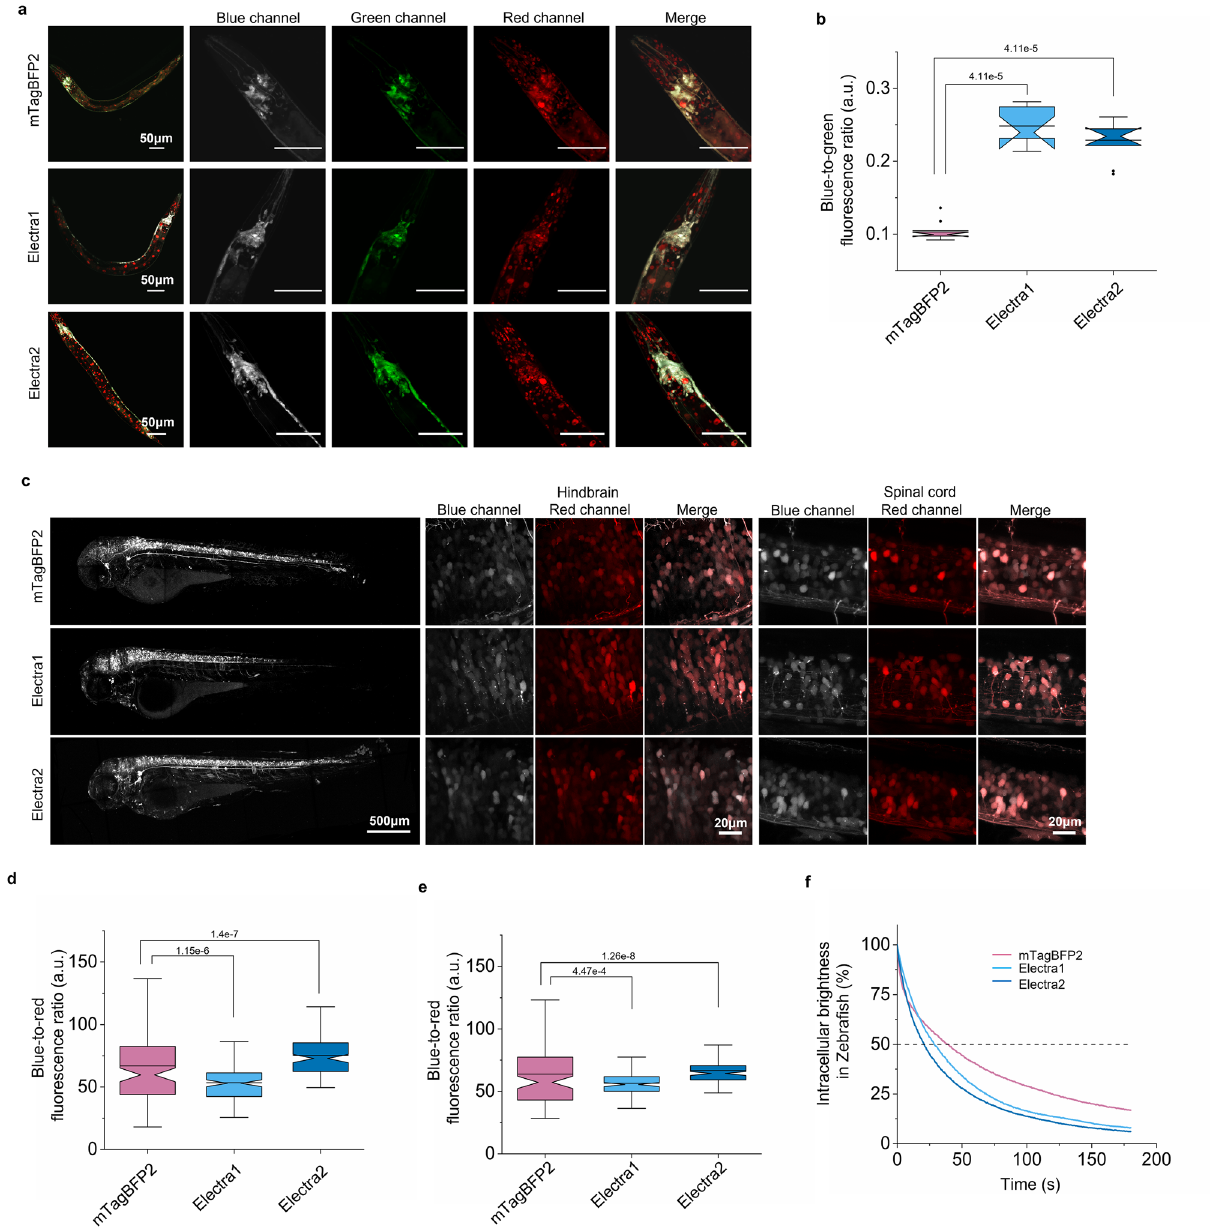
Figure 6. Fluorescence comparison of mTagBFP2, Electra1 and Electra2 in small model organisms. ( a ) Whole body images of representative C. elegans worms co-expressing mTagBFP2, Electra1 and Electra2 with mNeonGreen under pan-neuronal promoter tag168 and mScarlet in most somatic cells. Higher magnification images of neuronal ring under blue (shown in grey), green (mNeonGreen), red channel (mScarlet) and merged. Imaging conditions: 405 nm excitation for BFPs, 430–470 nm emission; 488 nm excitation for mNeonGreen, 500–540 nm emission; 561 nm excitation for mScarlet, 570–620 nm emission. The dynamic range of all images was adjusted independently to facilitate visualization. ( b ) Blue-to-green fluorescence ratio comparison in C. elegans neuronal ring ( n = 9 worms for each protein; Kruskal Wallis ANOVA p -value = 1.29e-4; post-hoc two sample Kolmogorov-Smirnoff p -values shown in graph; Supplementary Table S7). ( c ) Representative whole overview image of 4dpf zebrafish expressing each BFP throughout brain and spinal cord (left). Higher magnified images of blue, red, and merged fluorescence in hindbrain (middle) and spinal cord (right) neurons. Transient co-expression of each BFP and mScarlet was induced by injection into zebrafish embryos with a construct carrying each BFP-P2A-mScarlet whose expression is under the control of pan-neuronal nbt promoter. Imaging conditions: Blue channel: excitation 405 nm laser, emission 420–480 nm; red channel: excitation 561 nm laser, emission 565–606 nm). The dynamic range of all images was adjusted independently to facilitate visualization. ( d ) Blue-to-red fluorescence ratio comparison in zebrafish hindbrain expressing mTagBFP2, Electra1, Electra2 ( n = 116, 117, 116 neurons from 4 independent zebrafish; Kruskal–Wallis ANOVA p -value = 1.98e-19; post-hoc two sample Kolmogorov-Smirnoff p -values shown in graph; Supplementary Table S8; imaging conditions for BFPs: same as in ( a) ). ( e ) Blue-to-red fluorescence ratio comparison in zebrafish spinal cord neurons expressing mTagBFP2, Electra1, Electra2 ( n = 113, 118, 117 neurons from 4 independent zebrafish; Kruskal–Wallis ANOVA p -value = 1,2e-8; post-hoc two sample Kolmogorov-Smirnoff p -values shown in graph; Supplementary Table S8) with mScarlet. Imaging conditions for BFPs: same as in ( c ). ( f )Time-dependent blue fluorescence measurement for mTagBFP2, Electra1, Electra2 ( n = 40, 40, 40, respectively from 4 independent zebrafish) in spinal cord neurons. Imaging conditions of BFPs: Blue channel: excitation 405 nm laser, emission 420–464